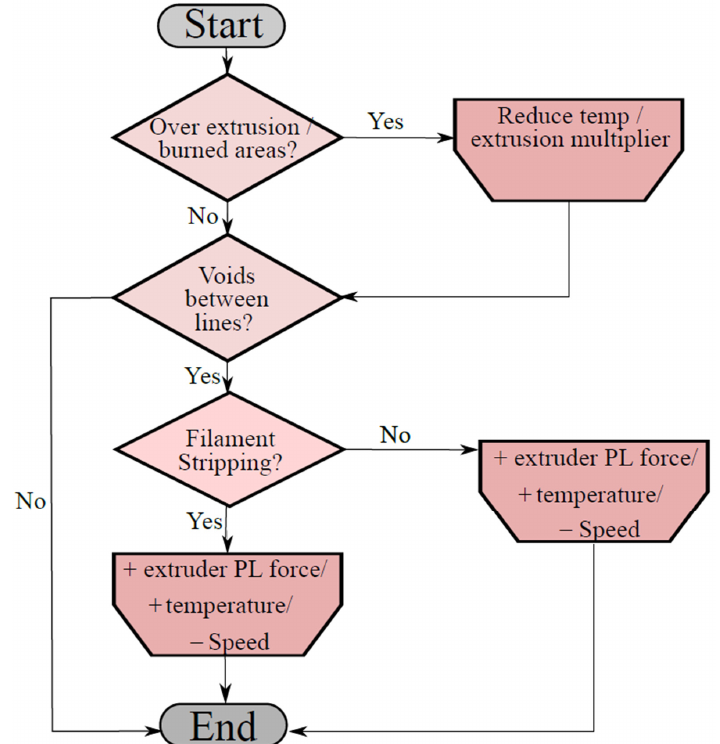
Polymers 2021 , 13 , 2190 Figure 15. Optimization process loop cycle. Figure 15. Optimization process loop cycle.